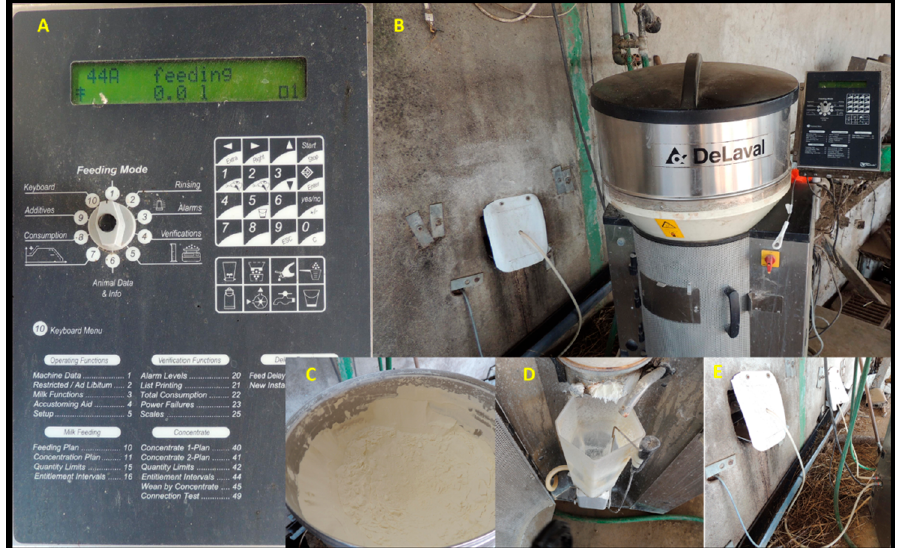
Figure 1. Automatic milk feeding system: ( A ) shows the control panel, where all the information relative to the calves and the machine is registered and controllable; ( B ) shows all the components (except the RFID reader and the teat, which are inside the calves’ barn); in ( C ) shows the milk powder deposit; ( D ) is the mixer cup, where each portion of milk is prepared with milk powder and heated water; in ( E ) is shown the circuit in which the milk departures from the mixing cup to the teat inside the calves’ barn.